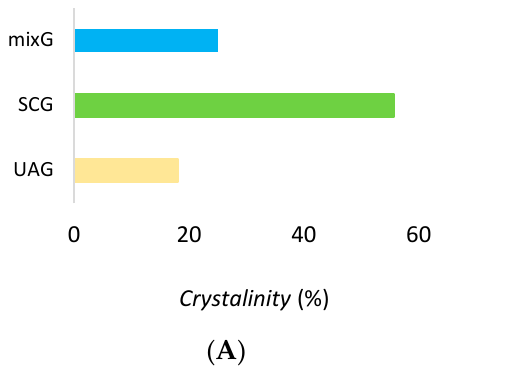
Figure 2. ( A ) The columns show the crystallinity profile. ( B ) XRD patterns of tree extracts showing intensity (A.U.) with respect to 2 Theta (°).